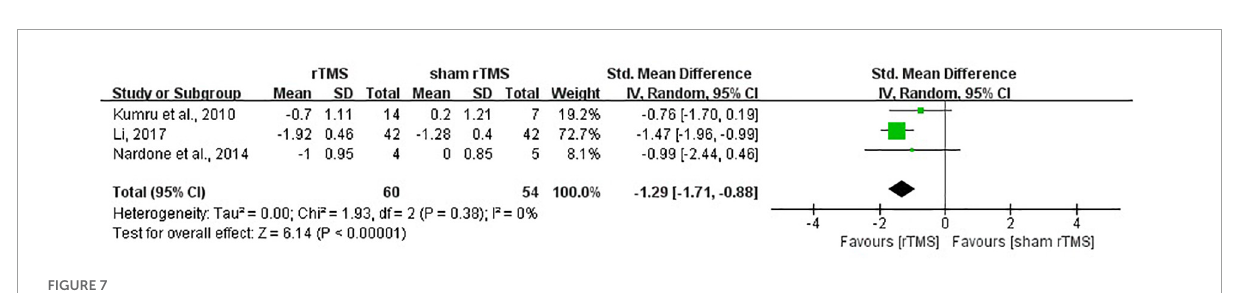
FIGURE6 The funnel plot of MAS in comparison of rTMS plus CR versus CR.